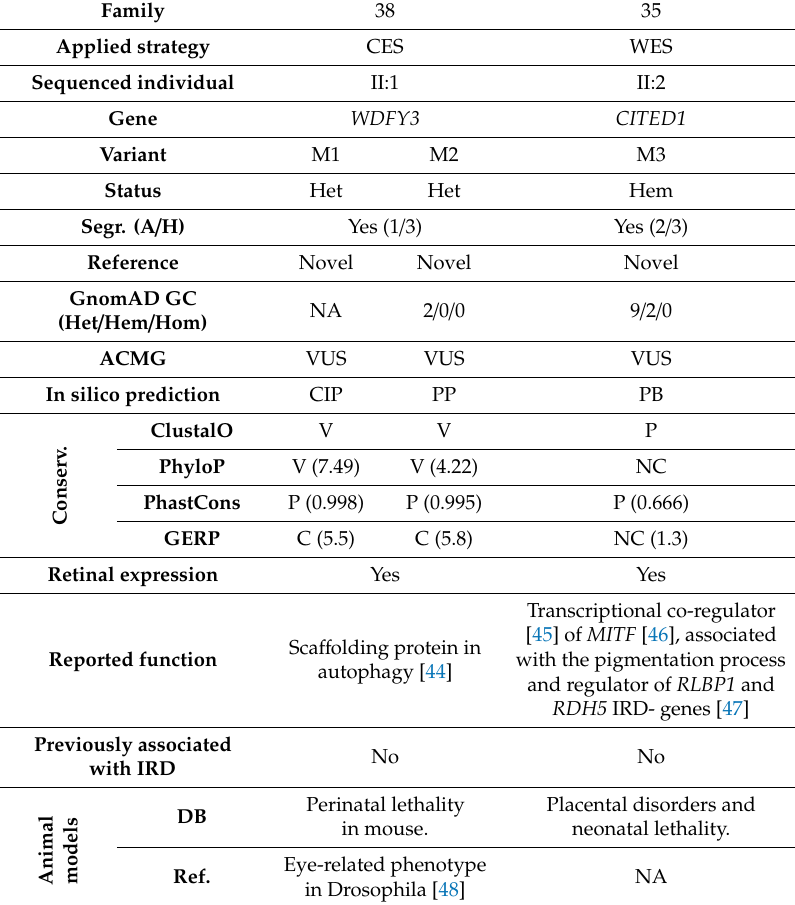
Table 3. Summary of data related to candidate genes and identified